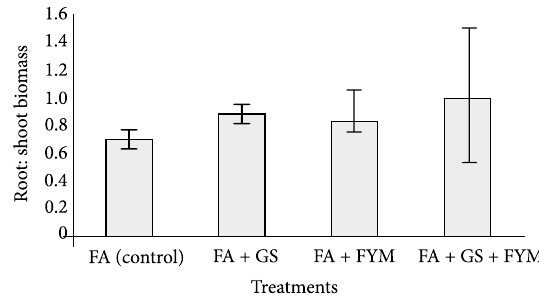
Fig. 5. Root is to shoot biomass ratio of Cymbopogon citratus grown of fly ash treatments compared to control having no